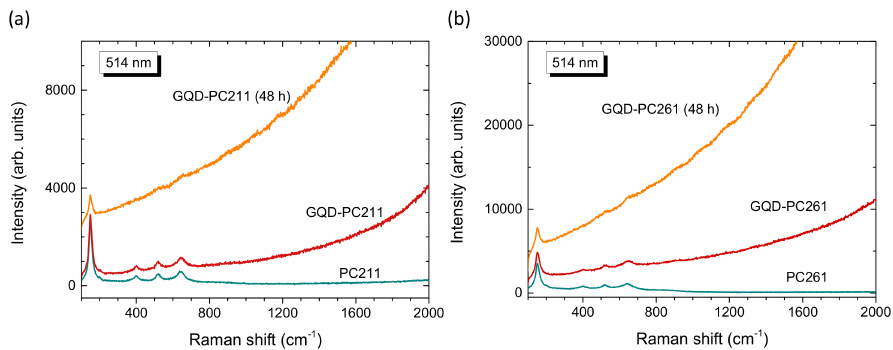
Figure 6. Raman spectra of the ( a ) PC211 and ( b ) PC261 films before and after GQDs’ surface modification at 514